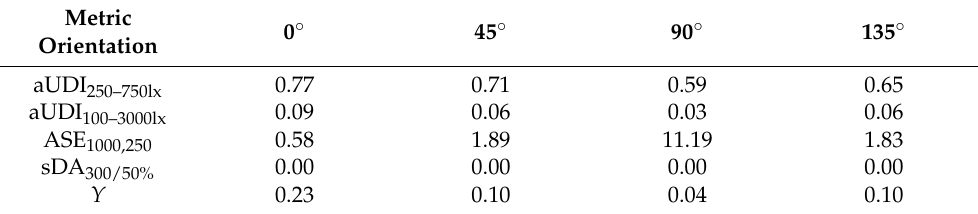
Table 6. Coefficient of variation (CV) values for each daylight metric at each orientation. Metric